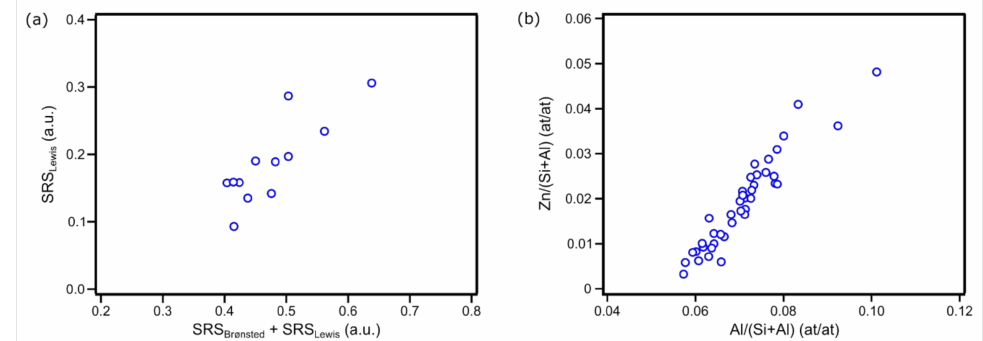
Figure 5. ( a ) Evolution of the SRS signal of complexed pyridine as a function of the total SRS signal (pyridinium cation and complexed pyridine) in Zn600 crystals. ( b ) Evolution of the Zn loading (Zn / (Si + Al) ratio) as a function of the Al content (Al / (Si + Al) ratio) in Zn600 crystals in Zn600 crystals, quantified by point EDX